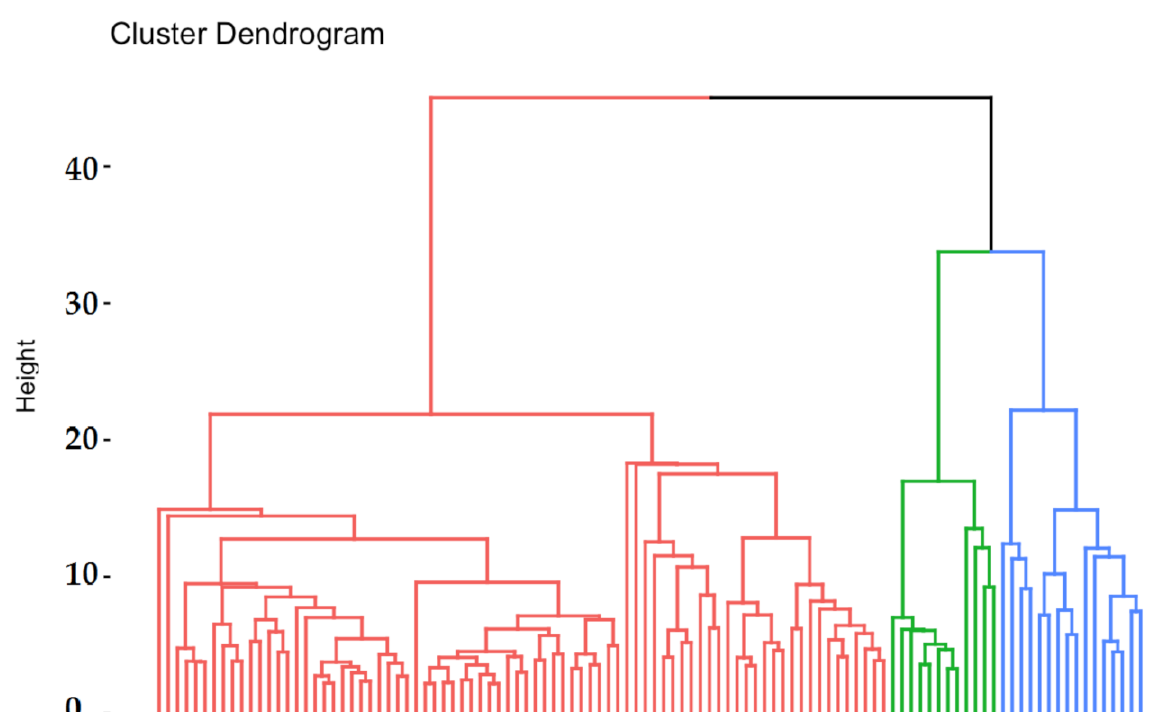
Figure 3. The results of Ward hierarchical cluster analysis. Based on distance (vertical axis), three clusters were chosen. The numbers on the X-axis represent the observation numbers.